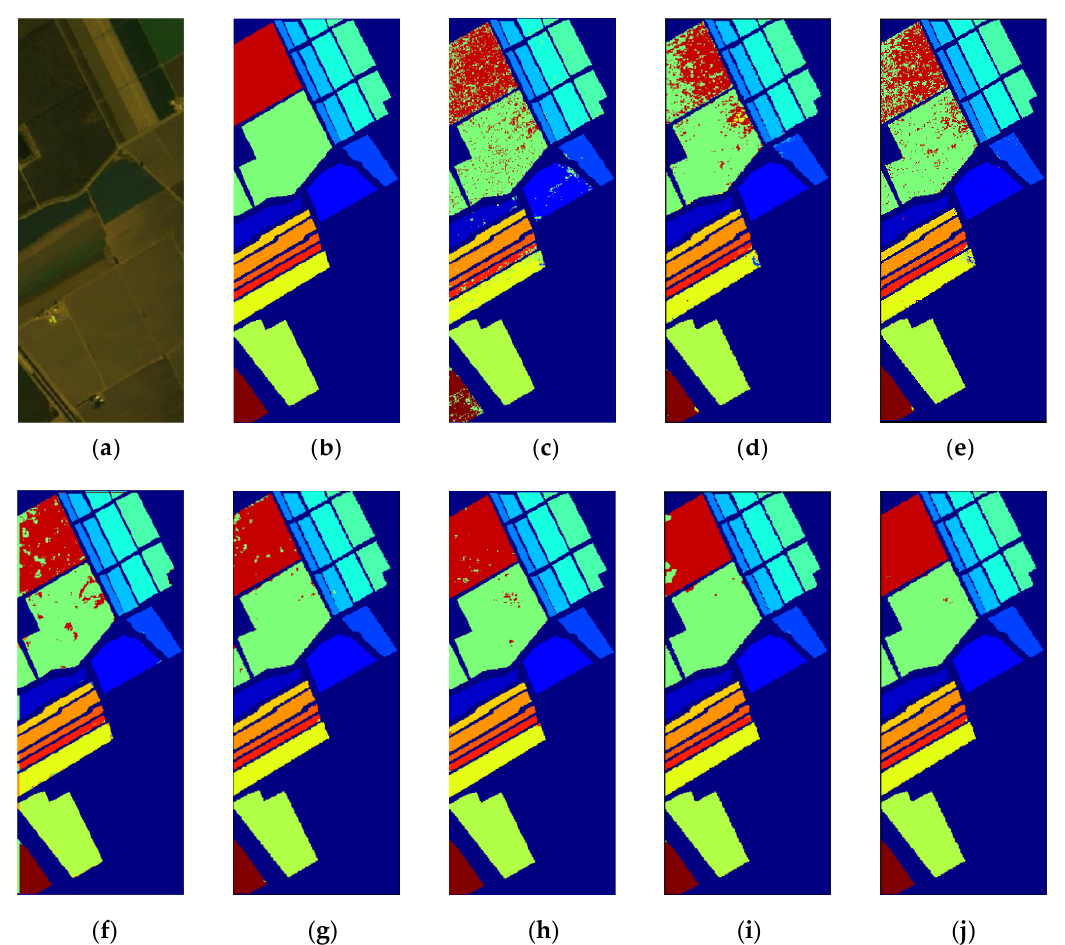
Figure 11. Classification maps for the Salinas scene dataset. ( a ) False-color image. ( b ) Ground truth. ( c ) SVM. ( d ) PCA. ( e ) LSTM. ( f ) 3DCNN. ( g ) SSRN. ( h ) DFFN. ( i ) MSCNN. ( j ) SSDF.